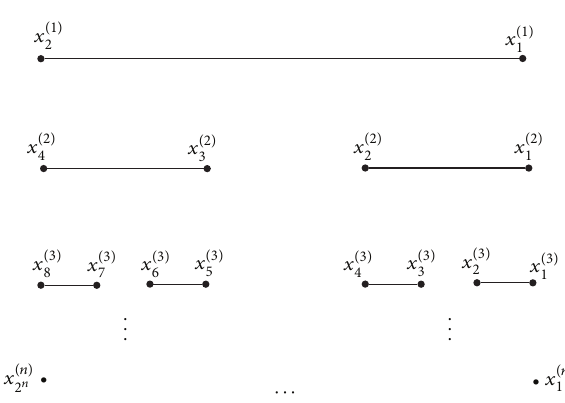
Figure 1: The Cantor ternary set is defined by repeatedly removing the middle thirds of line segments [8, 9]. (a) One starts by removing the middle third from the interval [𝑥 (1) 2 , 𝑥 (1) 1 ] , leaving [𝑥 (2) 4 , 𝑥 (2) 3 ] and , 𝑥 (2) ] . (b) Next, the “middle third” of all remaining intervals [𝑥 (2) 2 1 is removed. (c) This process is continued ad infinitum. Finally, the Cantor ternary set consists of all points in the interval [𝑥 (1) 2 ,𝑥 (1) 1 ] that are not removed at any step in this infinite